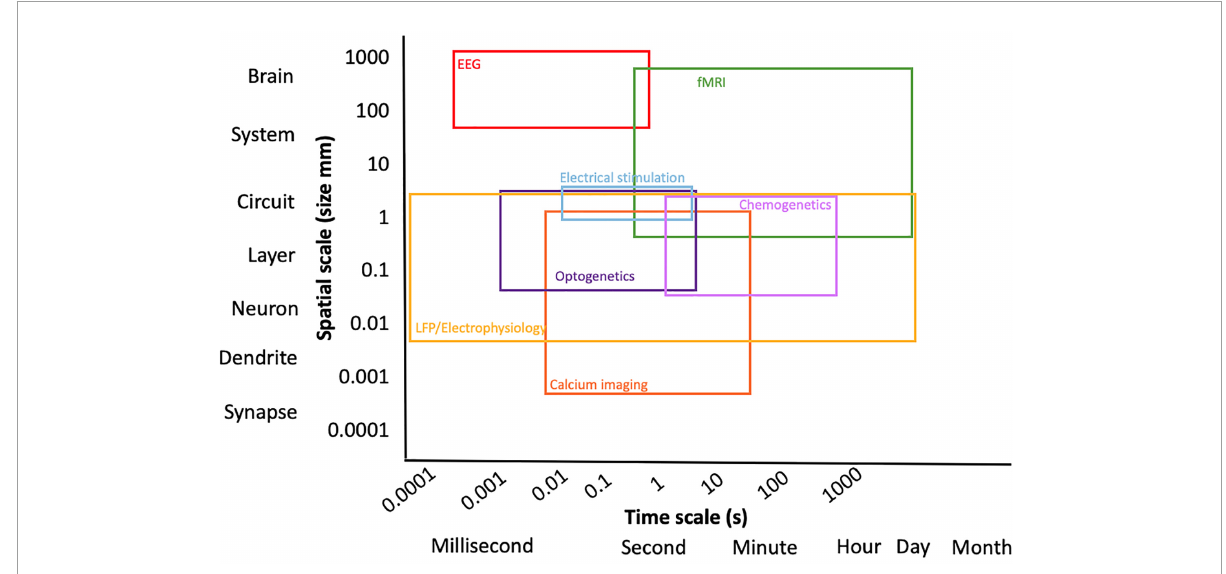
FIGURE1 Overview of multimodal techniques expanding the spatial and temporal resolution of the experiment.